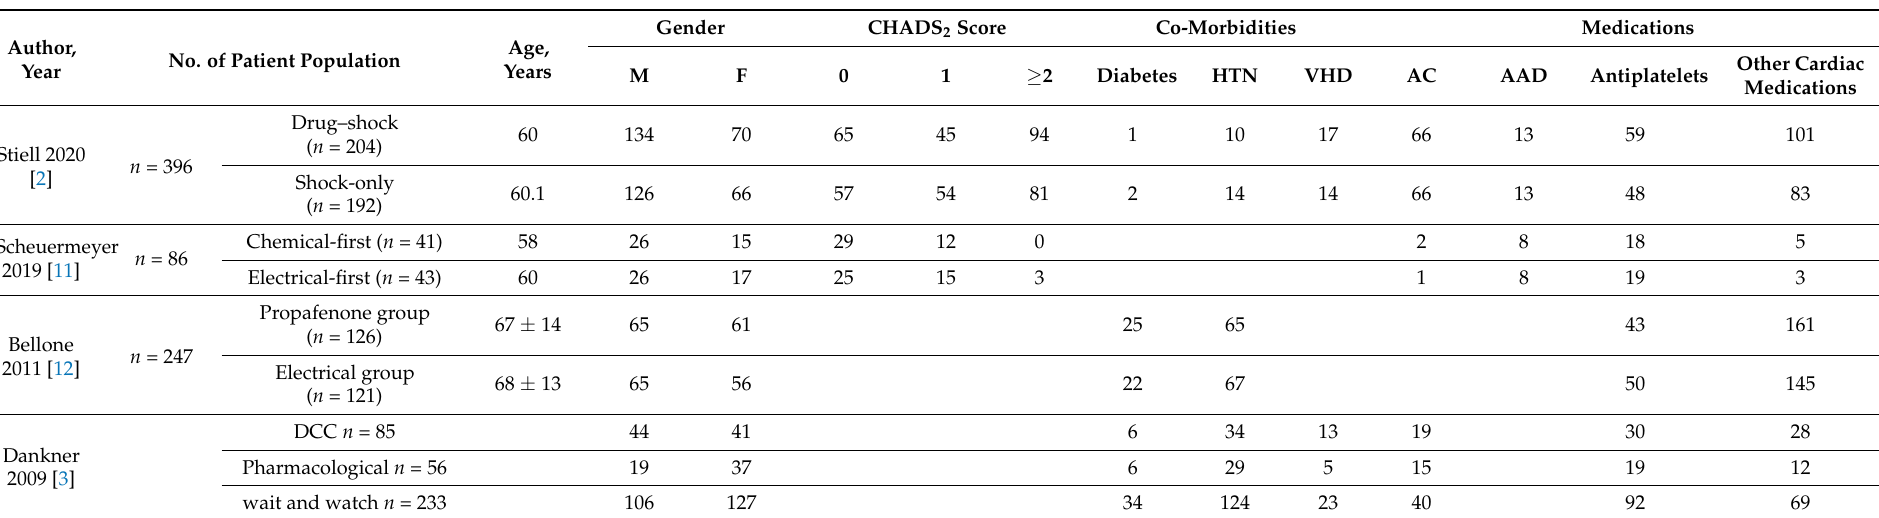
Table 2. Baseline characteristics of